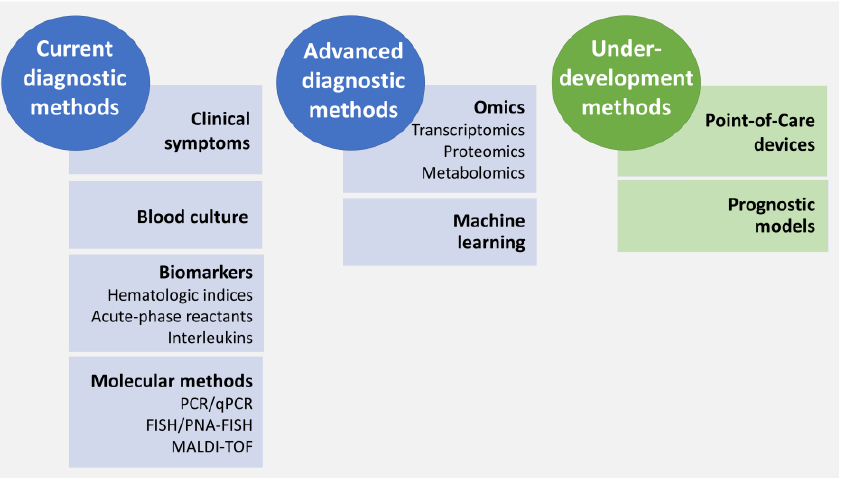
Figure 3. Summary of some of the currently used methods used for diagnosis of LOS, along with advanced and under-development methods. Of note, the list of techniques detailed under “current diagnostic methods” includes methods that are normally used alone, such as blood culture and those that are used as “add - on” tests, such as